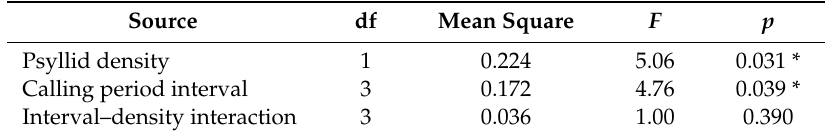
Table 1. Repeated measures analysis of variance for psyllid density, calling period intervals, and interaction between calling period interval and density in P 5 and P 25 psyllid density treatments. Source df Mean Square